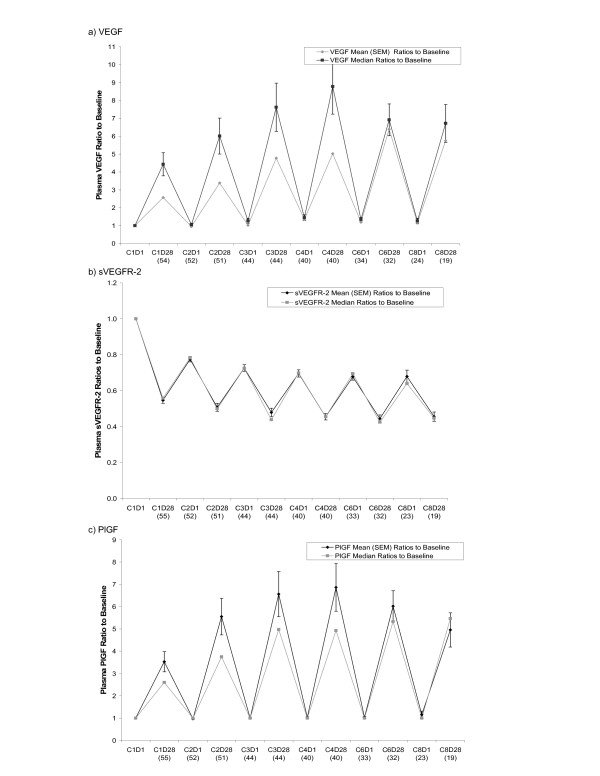
Mean and median ratios to baseline for VEGF (panel a), sVEGFR-2 (panel b), and PlGF (panel c) at each timepoint in various treatment cycles (SEM = Standard Error of the Mean). Soluble protein plasma level ratios relative to baseline (cycle 1, day 1) are plotted as a series of timepoints, with the baseline values normalized to 1. C(N)D(N) = cycle number, day number (e.g., C1D28 = cycle 1, day 28). The number of values available is listed in parentheses below each time point. The rise and fall of these proteins in accordance with the 4 weeks-on/2 weeks-off sunitinib dosing regimen is indicative of a drug-dependent effect.